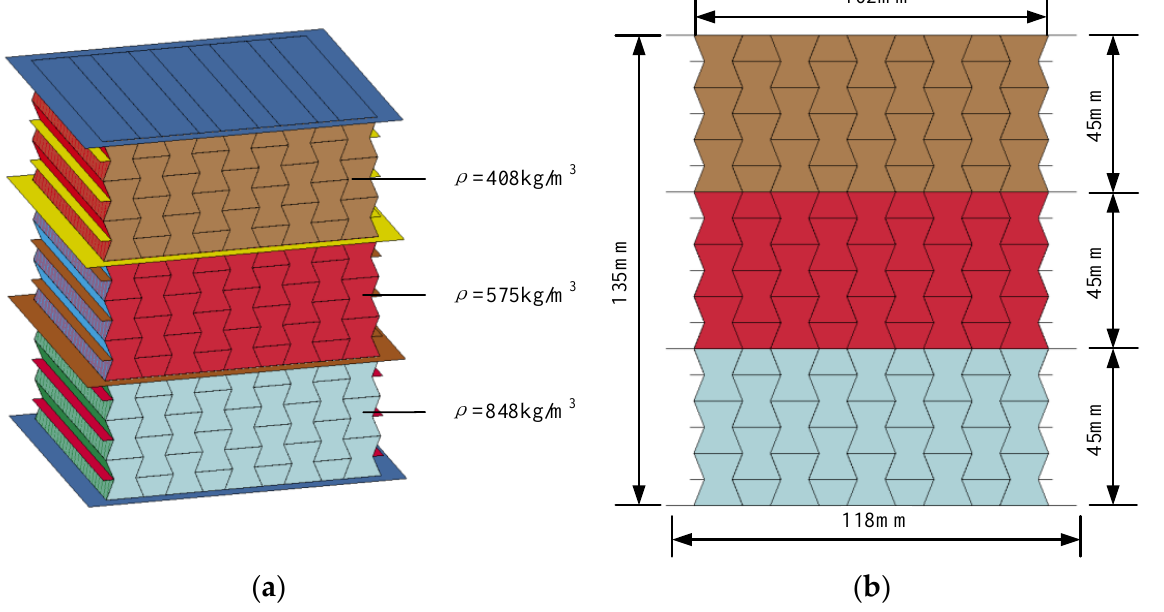
Figure 16. The numerical model and geometric parameters of the composite with foam concrete density gradient (1 m/s): ( a ) numerical model; ( b ) geometric parameters.